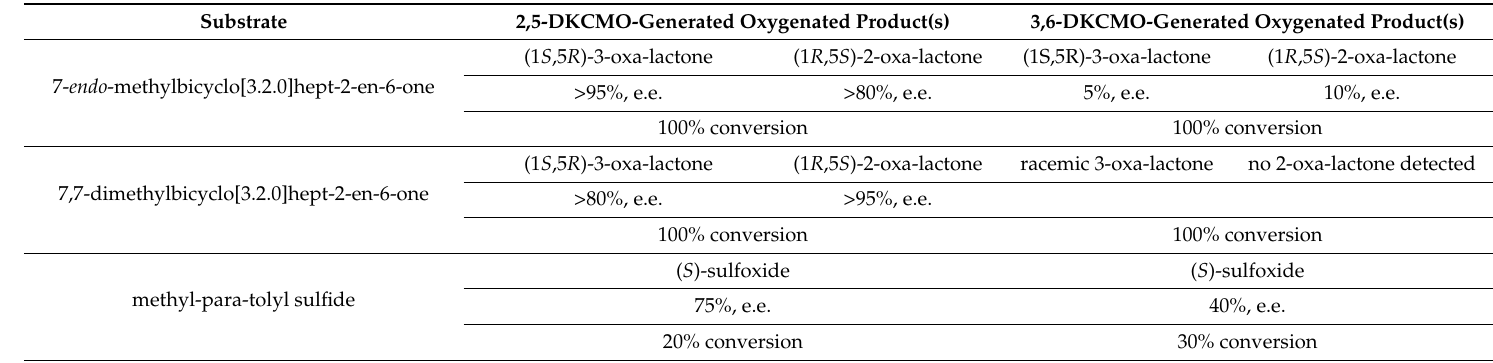
Table 2. Biotransformations of bicyclo[3.2.0] series ketones by highly purified preparations of 2,5-diketocamphane 1,2-monooxygenase and